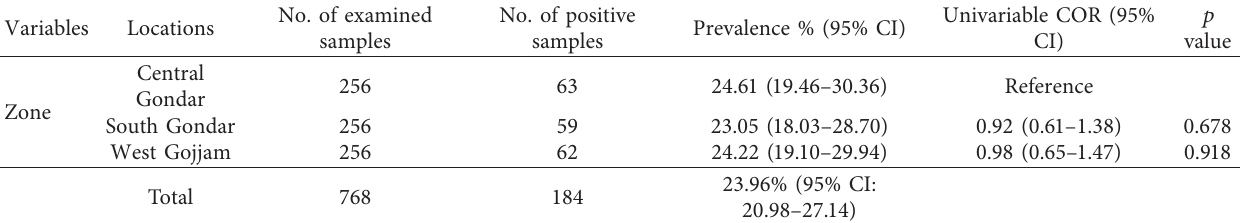
Table 1: Seroprevalence of IB in three different zones.